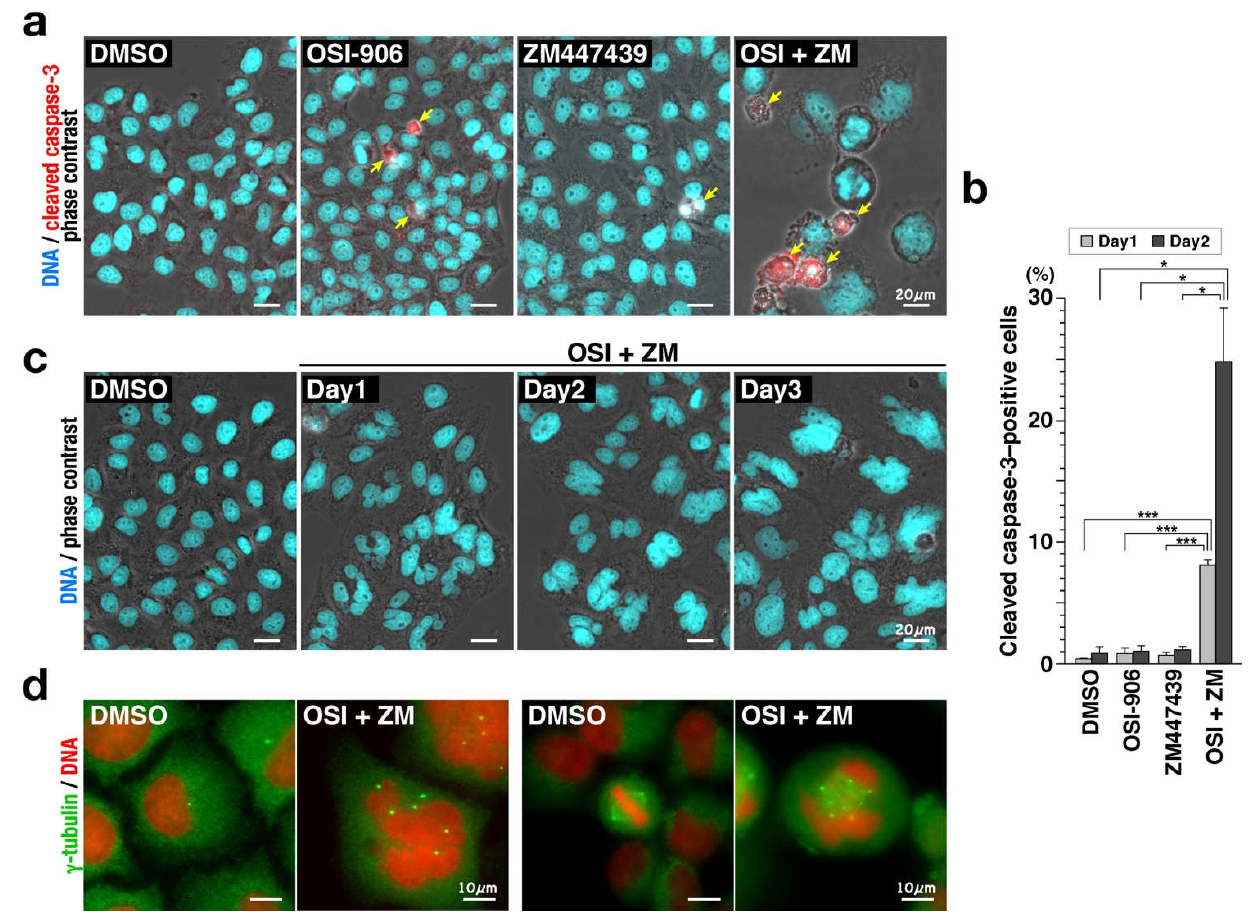
Figure 1. Combination of OSI-906 and ZM447439 generates enlarged cells with aberrant-shaped nuclei. HeLa S3 cells were treated with 3 µM OSI-906, 1 µM ZM447439, or their combination for 3 days. The cells were fixed with methanol for 5 min at −30 °C ( a , c , d ) or 4% formaldehyde for 20 min at room temperature ( b ). ( a ) The fixed cells (Day3) were stained for cleaved caspase-3 (red) and DNA (cyan). Representative images of cells treated with OSI-906, ZM447439, or their combination (OSI + ZM) are shown. Dimethyl sulfoxide (DMSO) was used as solvent control. Yellow arrows indicate cleaved caspase-3–positive cells. Scale bar, 20 µm. ( b ) On day 1 and day 2, the cells were fixed and stained for cleaved caspase-3 and DNA. The number of cleaved caspase-3–positive cells were counted and plotted as the mean ± SD calculated from three independent experiments (n > 201). p -values were calculated using Tukey’s multiple comparison test (Day1) and the Games–Howell multiple comparison test (Day2). * p < 0.05; *** p < 0.001. ( c ) The fixed cells were stained for DNA (cyan). Representative images of cells treated with the combination (OSI + ZM) for 1–3 days are shown. Scale bar, 20 µm. ( d ) The fixed cells (Day3) were stained for γ-tubulin (green) and DNA (red). Representative images of γ-tubulin in interphase (left) and M phase cells (right) treated with the combination (OSI + ZM) are shown. Scale bar, 10 µm.